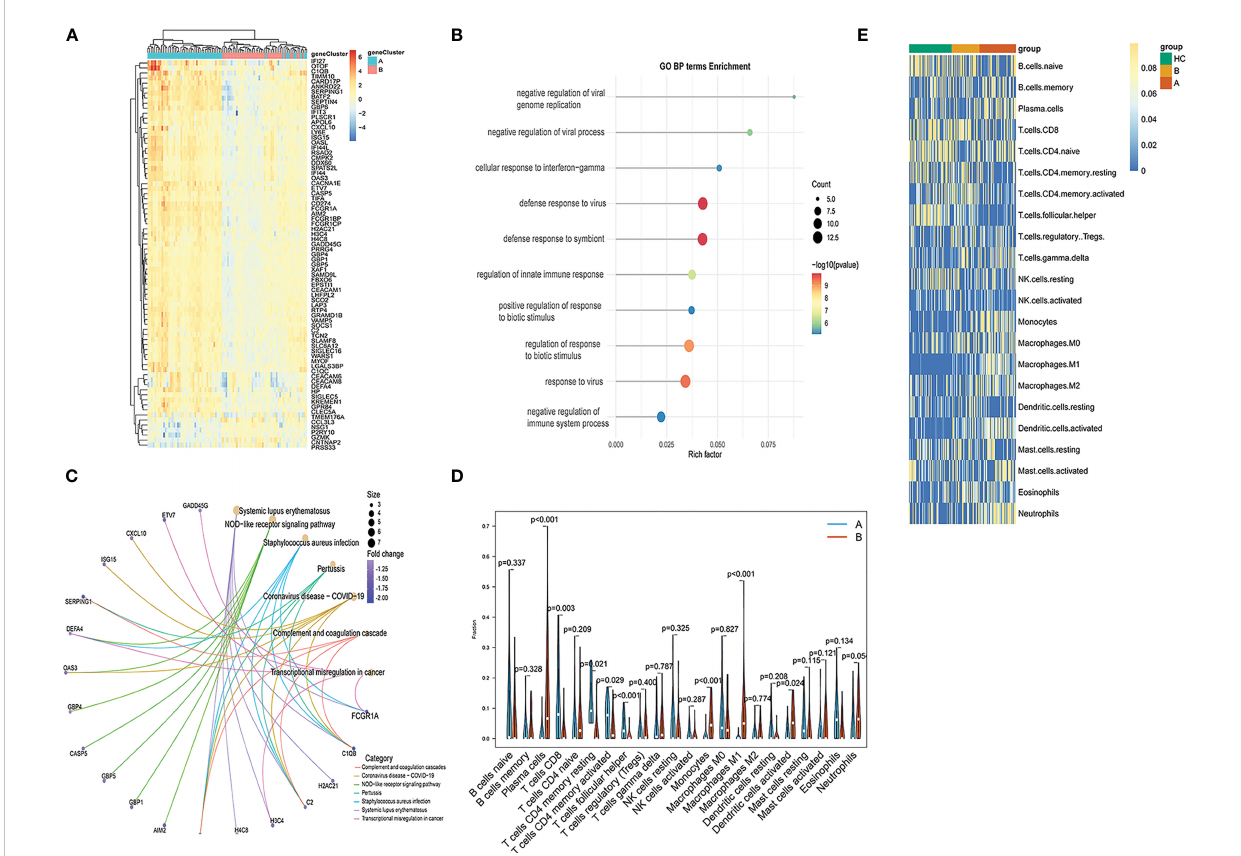
FIGURE 11 Functional enrichment analysis and immune cell enrichment analyses in different PCD-related patient subgroups. (A) DEGs arranged in volcano plots. (B) Enriched GO terms. (C) Enriched KEGG pathway analysis results. (D) Correlation matrix of all 22 immune cell subtype compositions. (E) Heatmap showing the relationship between gene expression levels and immune cell